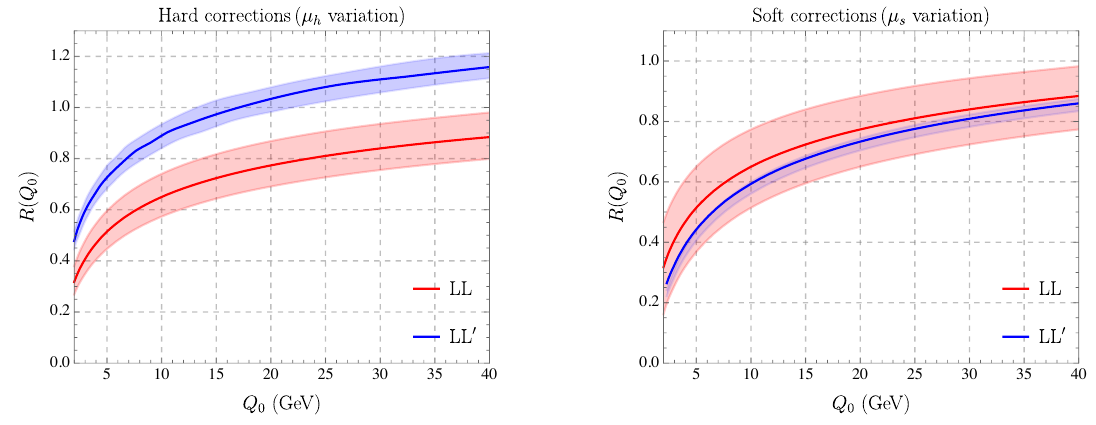
Figure 5 . Left panel: hard function corrections, with bands arising from hard scale variation. Right panel: soft function corrections, with bands from soft scale